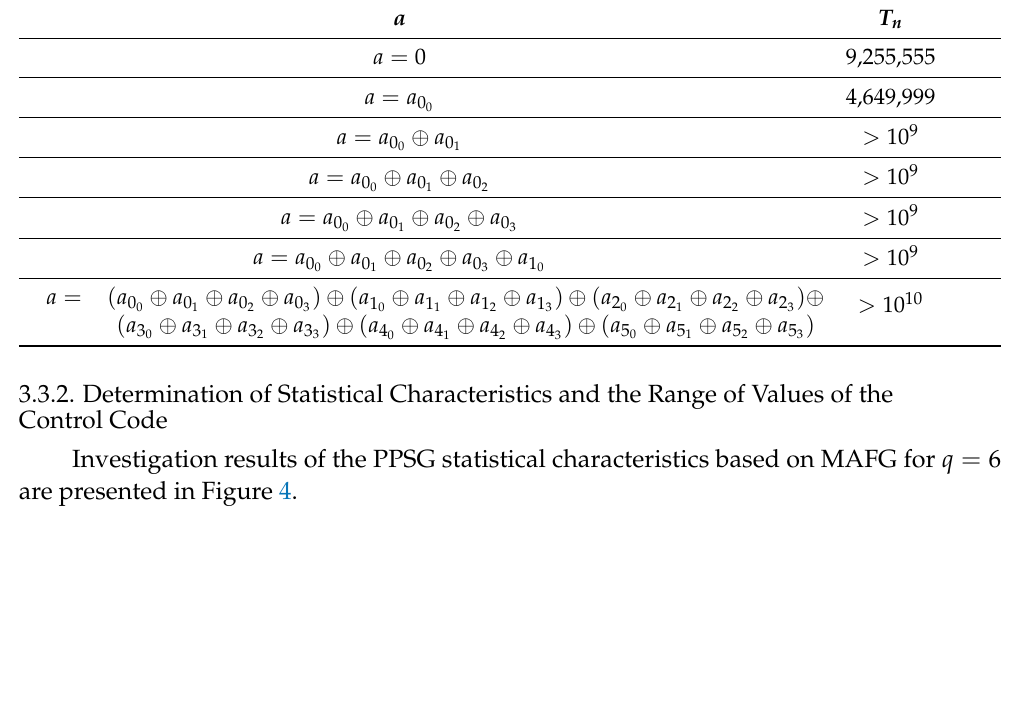
that dependence. G—control code value. of